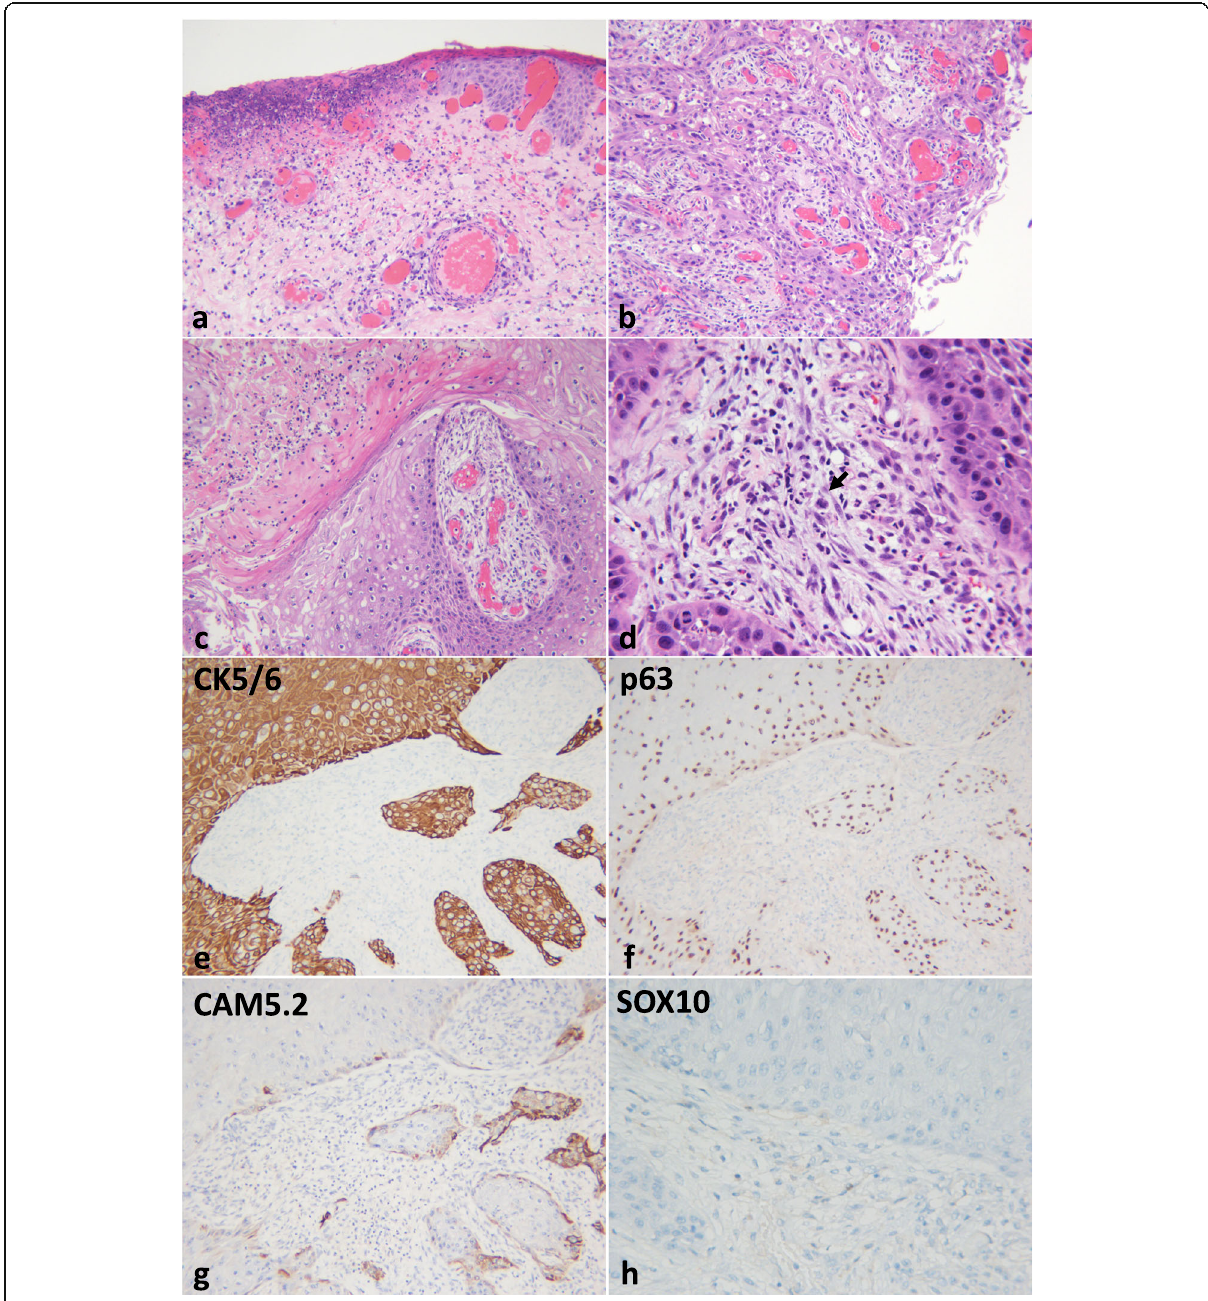
Fig. 4 Microscopic and immunohistochemical examinations for the left breast lesion. a Skin ulceration with congested blood vessels in dermis. Squamous epithelium adjacent to the ulceration appeared unremarkable. b Examination of the central cyst of the left breast lesion revealed cystic lining by squamous cell carcinoma. c Nests of squamous cell carcinoma with prominent keratinizing was noted diffusely in the lesion. d Stromal spindle cells were mixed with acute and chronic inflammatory cells. Very rare mitotic figure was noted (arrow). e Immuostains for CK5/6, f p63 and g CAM5.2 showed positivity in squamous cell carcinoma, but were are negative in the spindle cell component. h Both the squamous cell carcinoma and the spindle cell component were negative for SOX10 immunostain. (Hematoxylin-eosin, original magnification × 10 [ a , b , c ], 20x [ d , h ]; Immunohistochemistry, original magnification × 10 [ e , f , g ], × 20 [ h